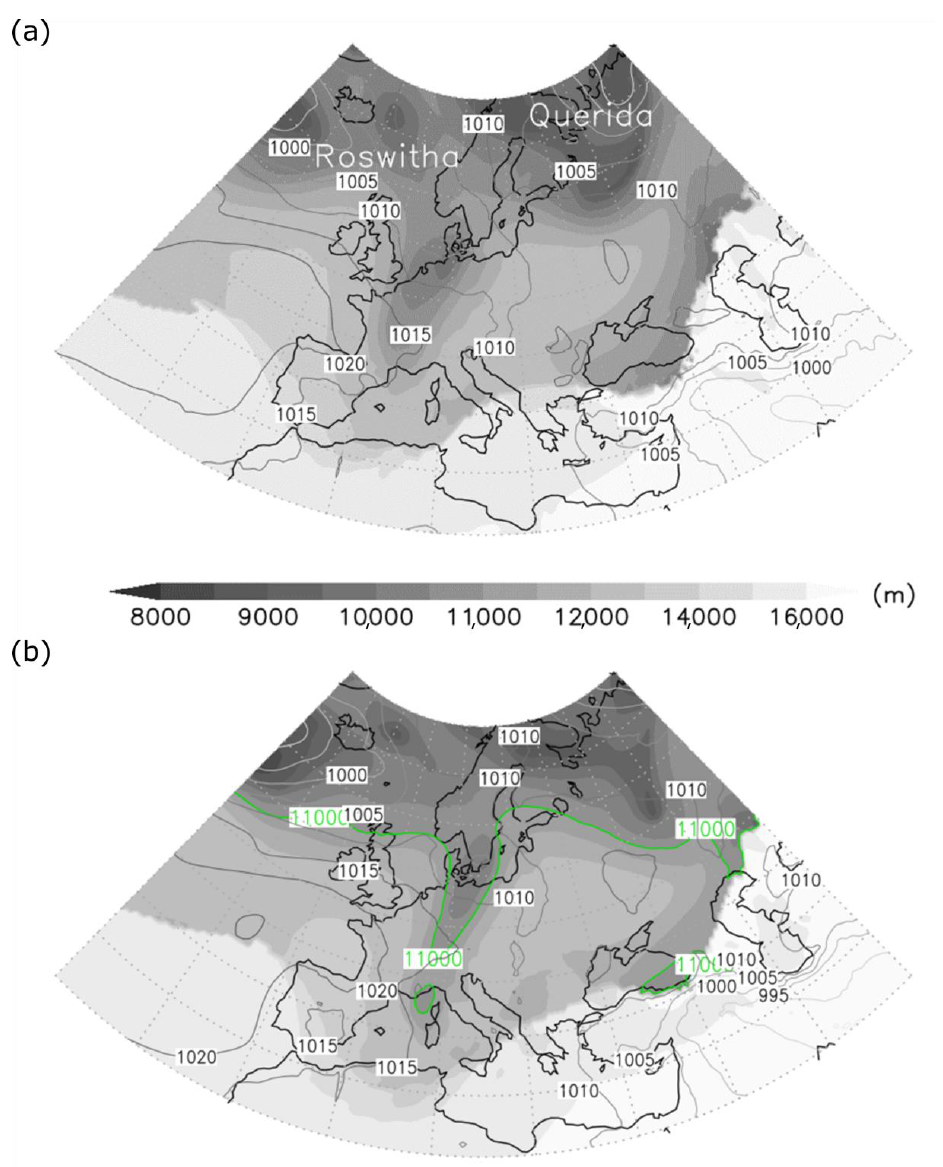
Figure 3. Mean sea level pressure (contours in hPa) and tropopause height (shaded contours in m) over Europe from the Global Forecast System (GFS) analysis ( a ) at 00:00 UTC and ( b ) at 12:00 UTC. The green contour shown in the panel below corresponds to the cutoff that occurred over the Ligurian Sea in the morning on 14 August 2018.